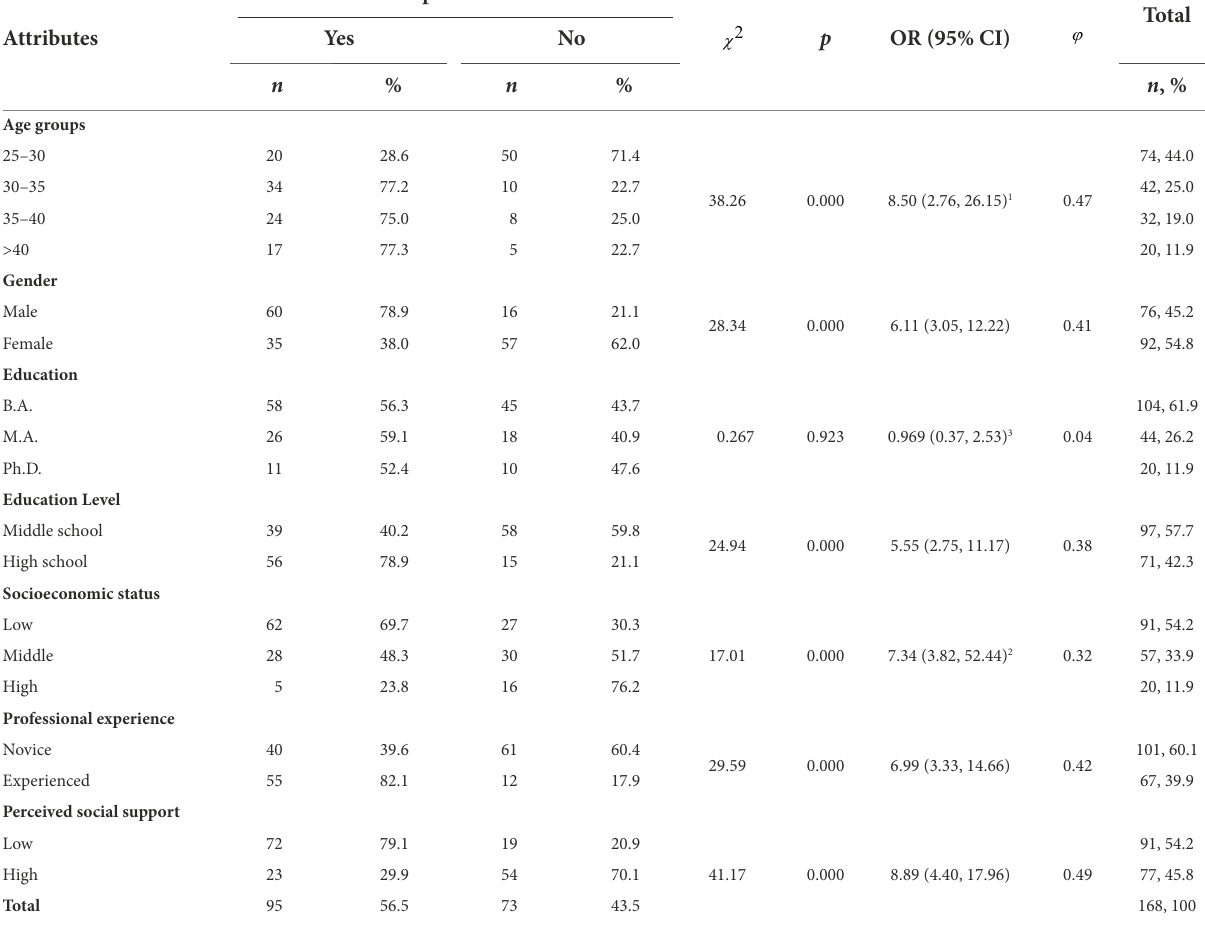
TABLE 2 Prevalence of hopelessness based on demographic and occupational attributes.